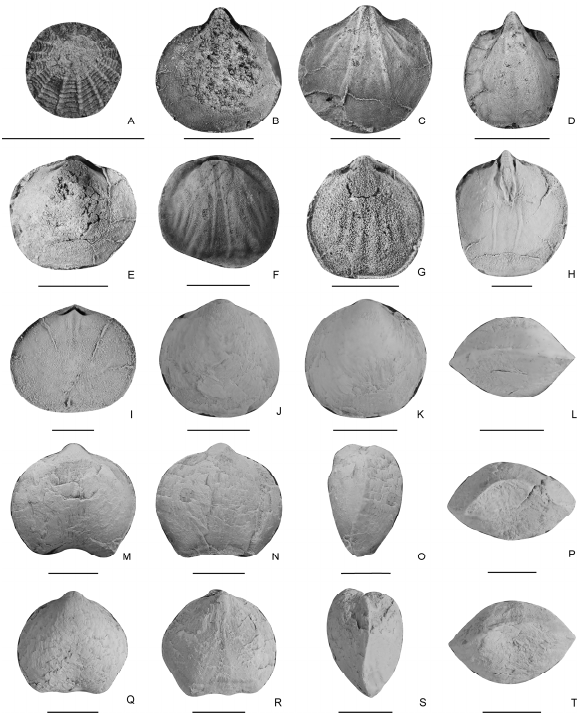
Figure 4. ( A ), Isocrania sp., ventral valve, LD380288. ( B – E ), Dioristella indistincta , ( B – D ), internal moulds of ventral valve, LD380119, LD380219, LD380396; I, an internal mould of a dorsal valve, LD380413. ( F – G ), Dioristella sp., internal moulds of dorsal valves, LD380200, LD380141. ( H – L ), Spirigerellina concentrica , ( H ), an internal mould of a ventral valve, LD385533; ( I ), an internal mould of a dorsal valve, LD385605; ( J – L ), ventral, dorsal and anterior views of a conjoined shell, LD385352. ( M – T ), Spirigerellina pygmaea , ventral, dorsal, lateral and anterior views of two conjoined shells, LD385207, LD385260. In ( A – L ), scale bar = 2 mm, in ( M – T ), scale bar = 5 mm.